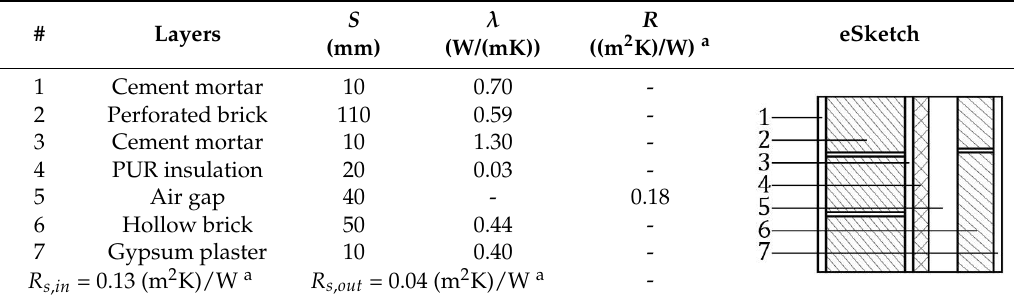
Figure 3. Thermographies of the analysed building carried out according to the ISO standard 6781 [47]. Table 1. Layer thickness and thermophysical properties of the building façade.